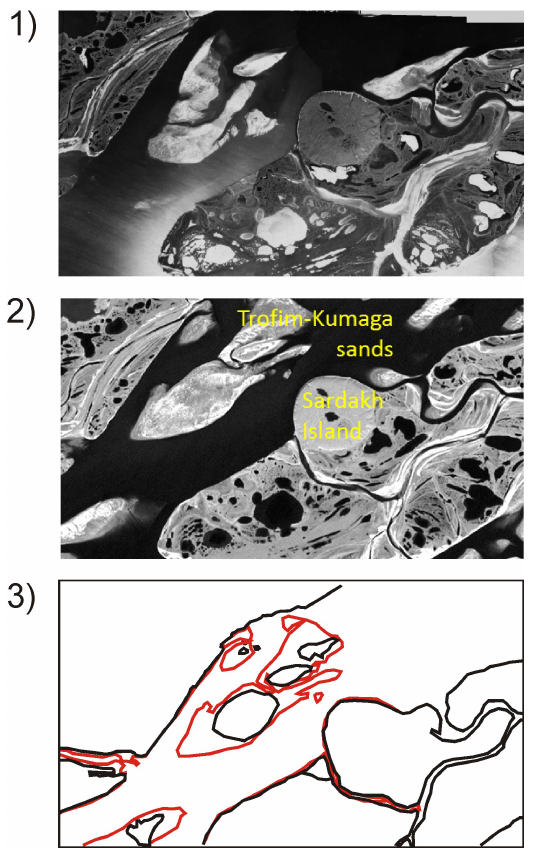
Figure 8. Changes of areal extent of the Trofim-Kumaga sandbanks in the Trofimovskaya branch close to Sardakh Island area: (1) on 10 July 1951 (aerial image), (2) on 5 August 2000 (Landsat TM satellite image), (3) digitized contours of islands, watercourses, and water basins (red contour line for 1951, black for 2000).